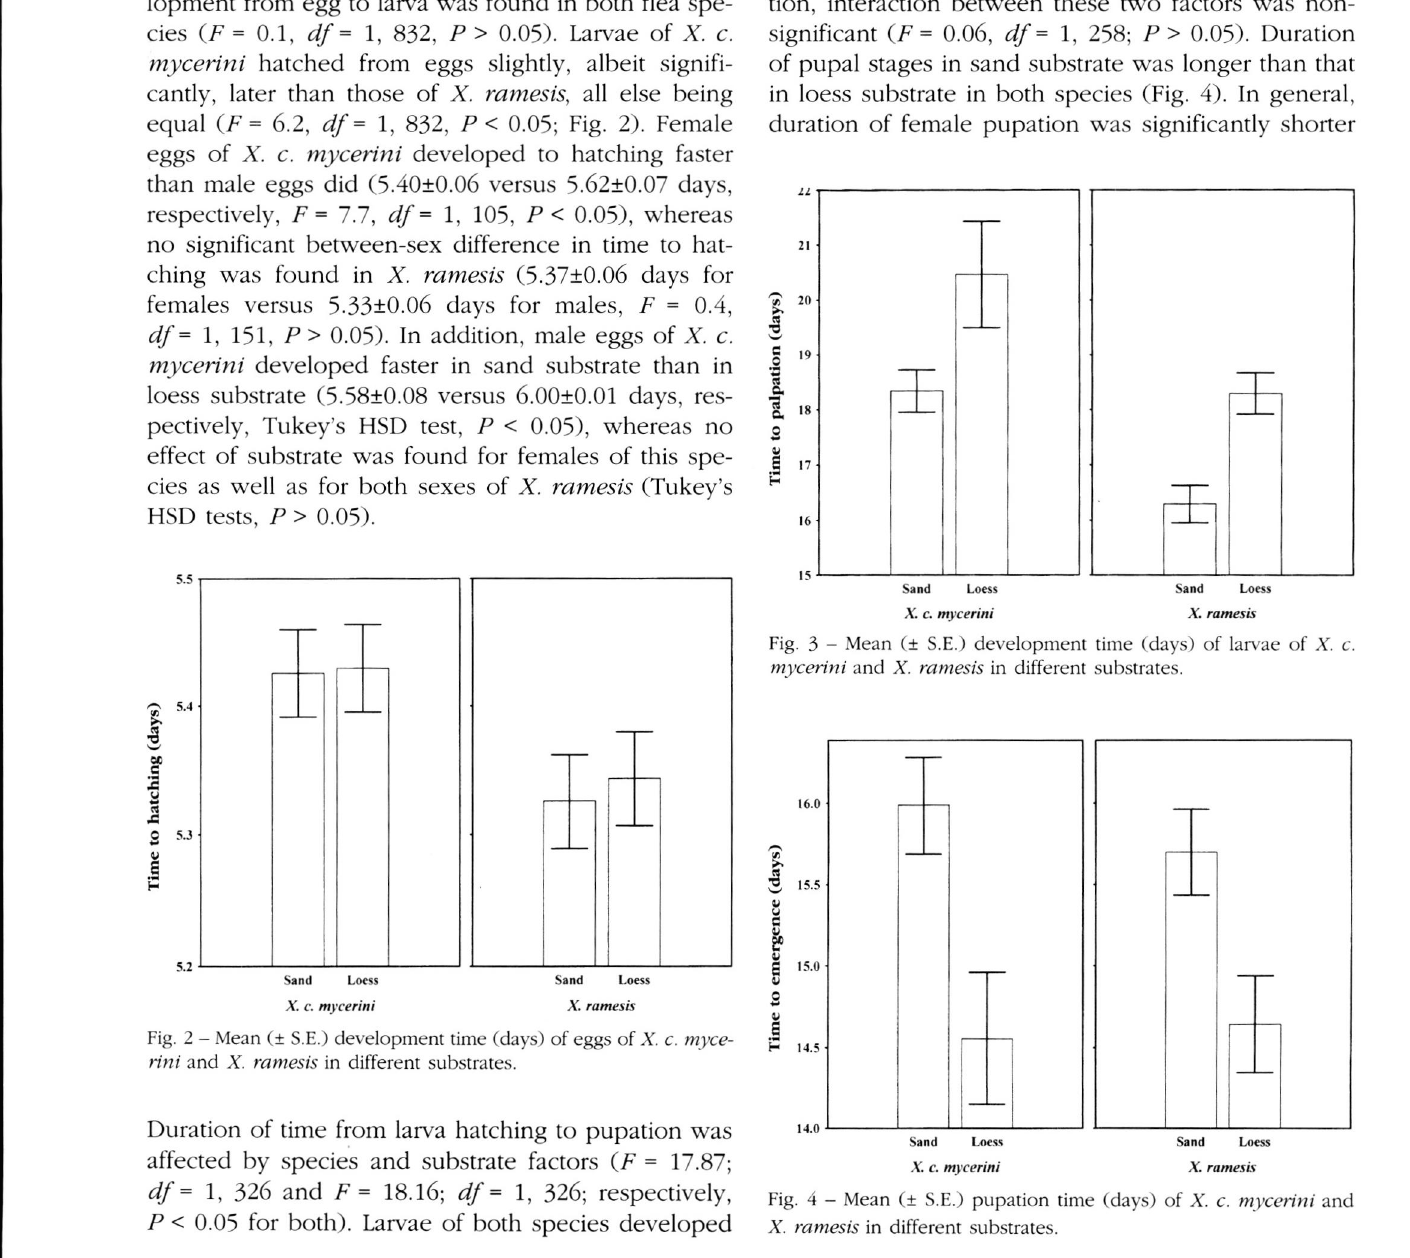
Fig. 4 - Mean (± S.E.) pupation time (days) of X. c. mycerini and X. ramesis in different